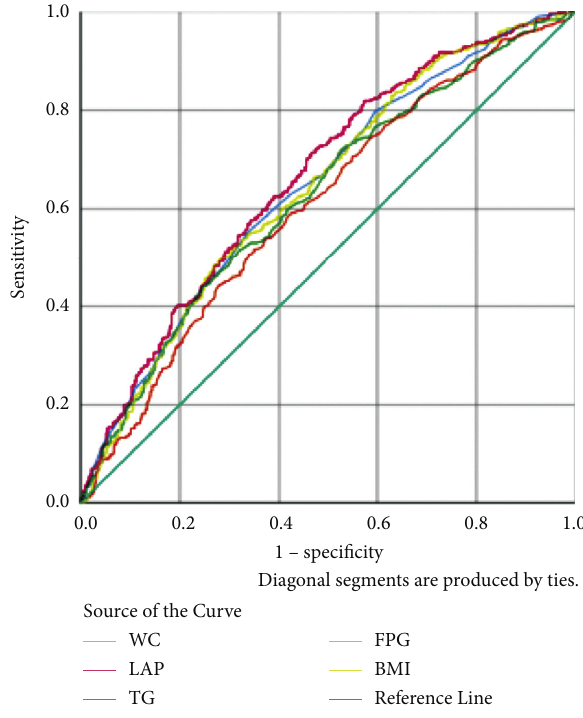
Figure 2: ROC curve in